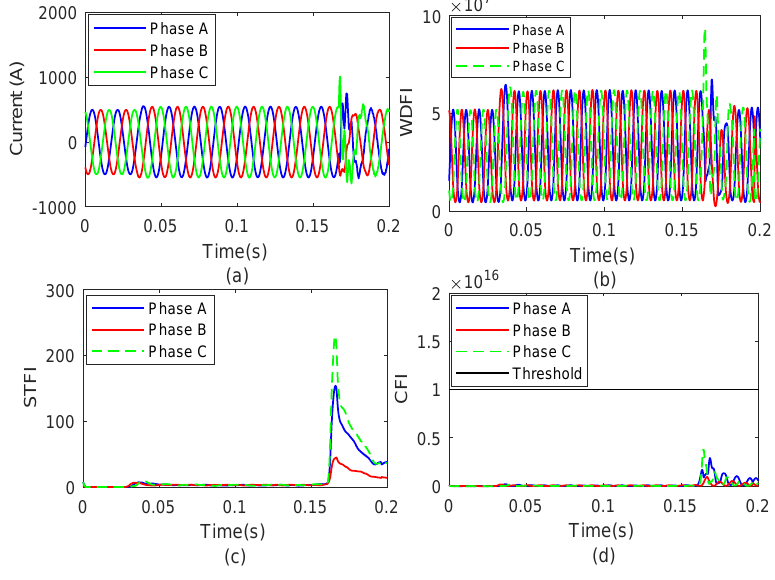
Figure 15. Event of capacitor switching ( a ) current waveform ( b ) WDFI ( c ) STFI ( d )